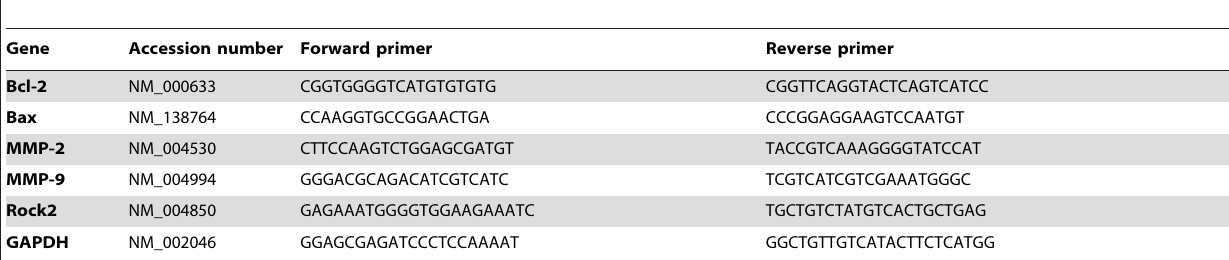
Table 1. Primer sequences used for the real-time quantitative reverse transcription-PCR assays.